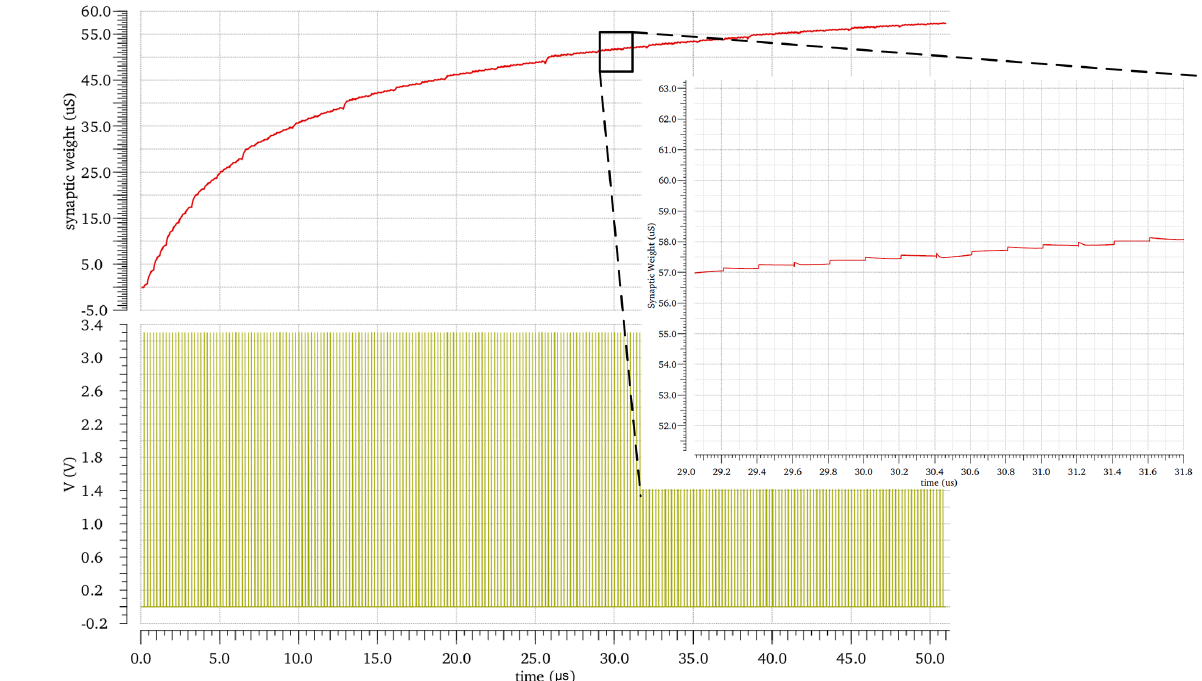
Figure 29. The synaptic weight behavior LTP at vg1 equals 1.5V, which is achieved by 256 input pulses applied to the 8bit counter, whose outputs control the 8bit binary digitized transistor of the synapse. Circuit conditions are V dd of 3 . 3V, and temperature equals 27 ◦ C and on the nominal process. The vg2 has a same influence on the second synapse of ACD.